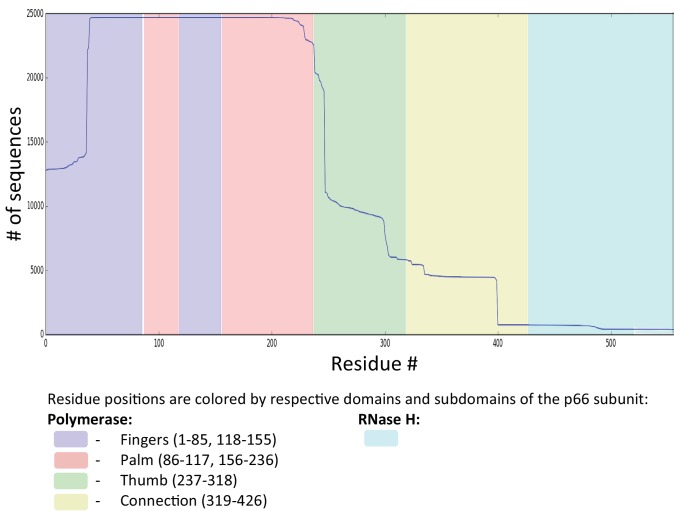
Sequence coverage for RT.Figure shows the sequence coverage (# of sequences vs the # of residues) for RT drug-experienced (both NRTI and NNRTI) sequences derived from the Stanford HIVDB (22,444 isolates from 20422 patients). For RT, sequences with exposure to both NRTIs and NNRTIs were selected as an alternate search for RT sequences exposed to only NRTIs or NNRTIs would return a vastly smaller number of isolates (5398 and 80, respectively). Sequences with insertions (‘#‘) and deletions (‘ ~‘) are removed. MSA columns and rows with more than 1% gaps (‘.’) are removed. This resulted in a final MSA size of N = 19194 sequences from 17130 persons each with length L = 188 for RT. To retain enough sequence coverage in the MSA, we removed residues: residues 1–38, and residue 227 onwards for RT. For this reason, some interesting DRMs like F227I/L/V/C, L234I, P236L or N348I (NNRTI affected) for RT are not amenable for our analysis.